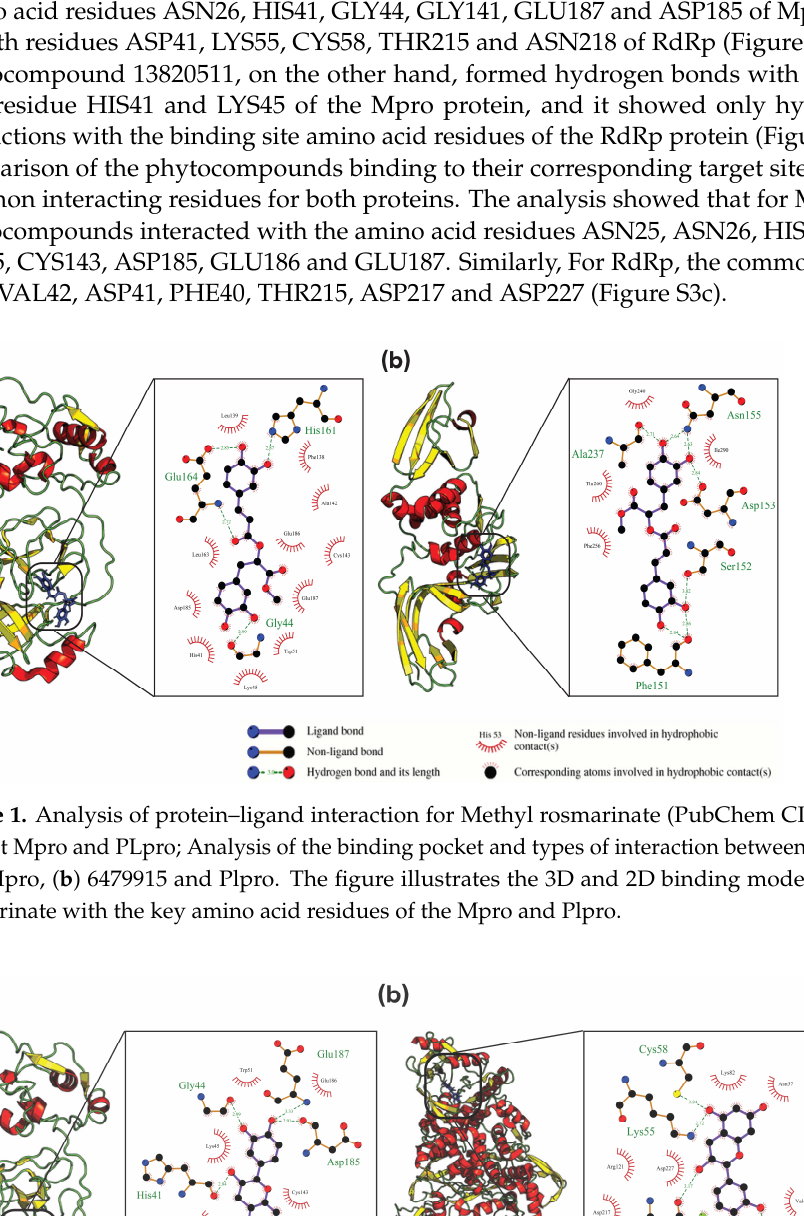
Figure 2. Analysis of protein–ligand interaction for Cianidanol (PubChem CID: 9064) against Mpro and RdRp; Analysis of the binding pocket and types of interaction between ( a ) 9064 and Mpro, ( b ) 9064 and RdRp. The figure illustrates the 3D and 2D binding modes of Cianidanol with the key amino acid residues of Mpro and